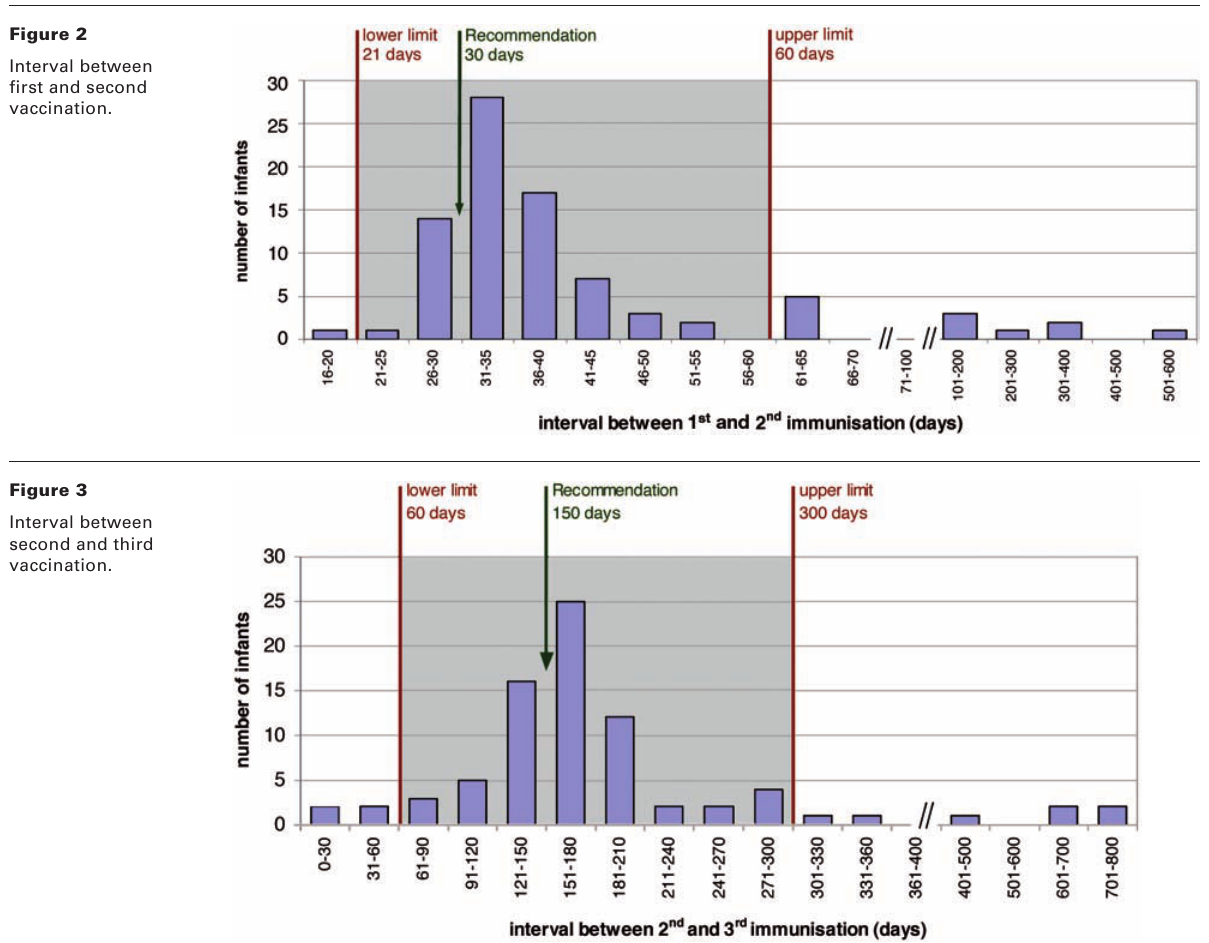
Figure 2 Interval between first and second vaccination.